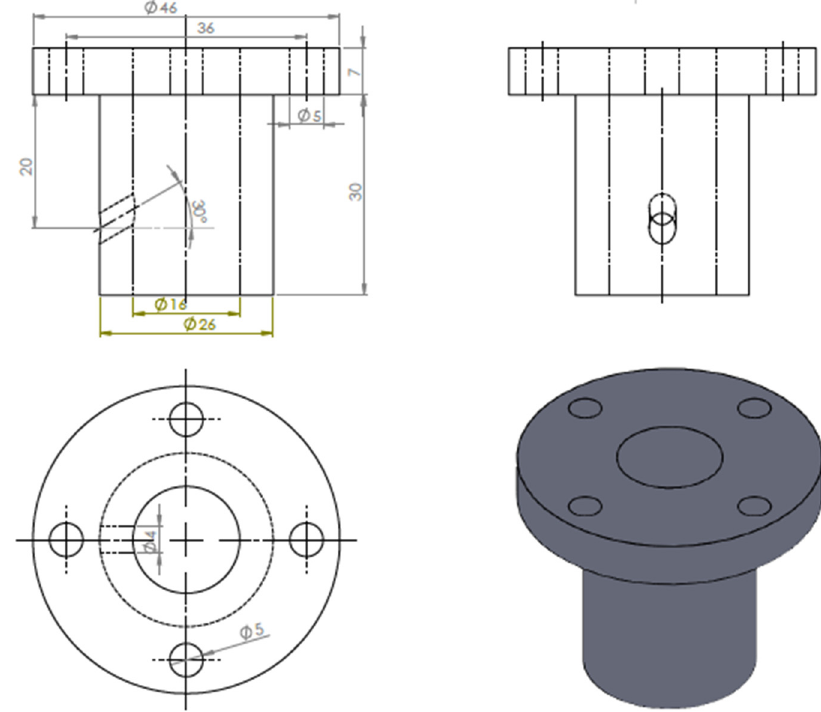
Figure 28. The jig views.